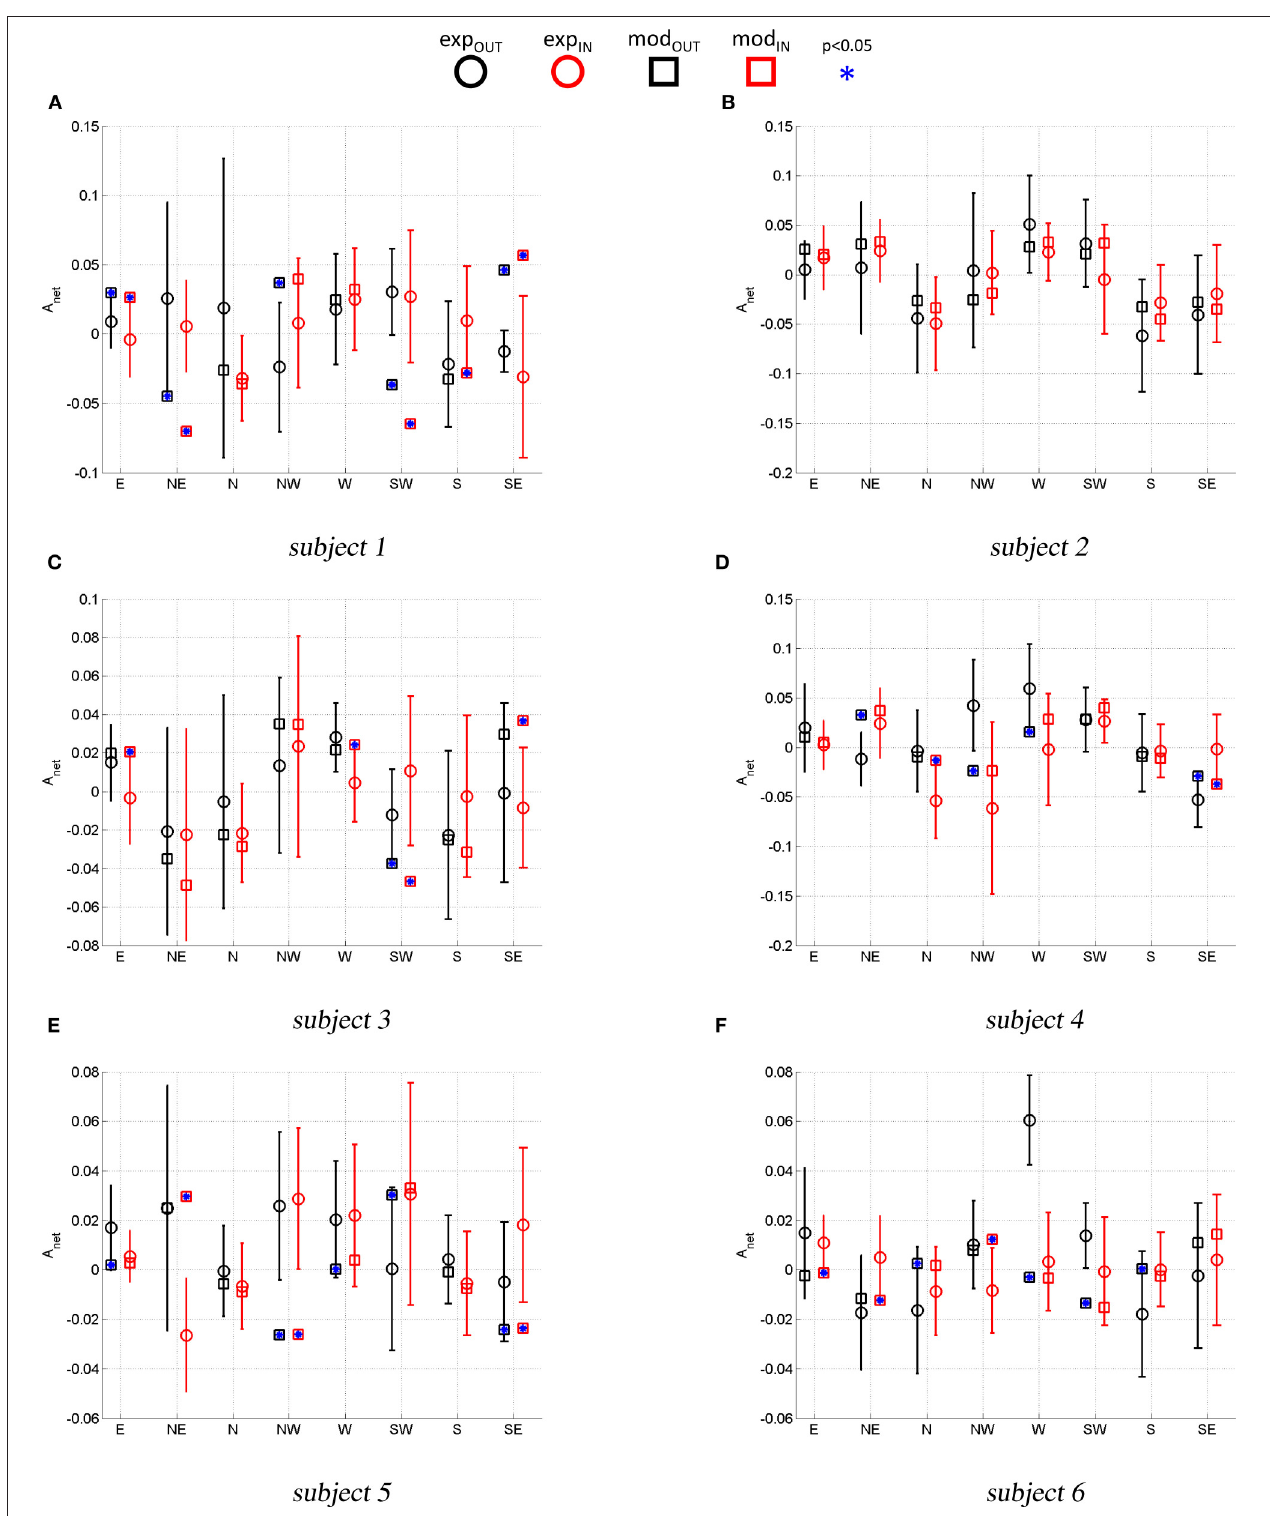
FIGURE 6 | Experimental vs. Model predicted A net . Error bars represent the standard deviation of the experimental ANET. Stars mark a model-predicted Anet that is statistically different ( p < 0.05) from the average experimental Anet.